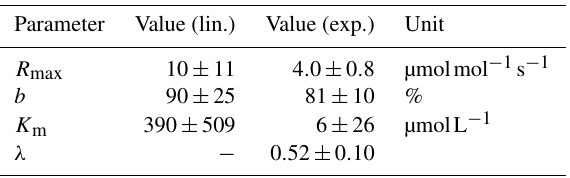
Table 1 and Table 2, respectively. R max is the maximum decomposition rate, b is the fraction of O 2 consumption, K m is the Michaelis constant for O 2 limitation, and λ is the exponential pH limitation